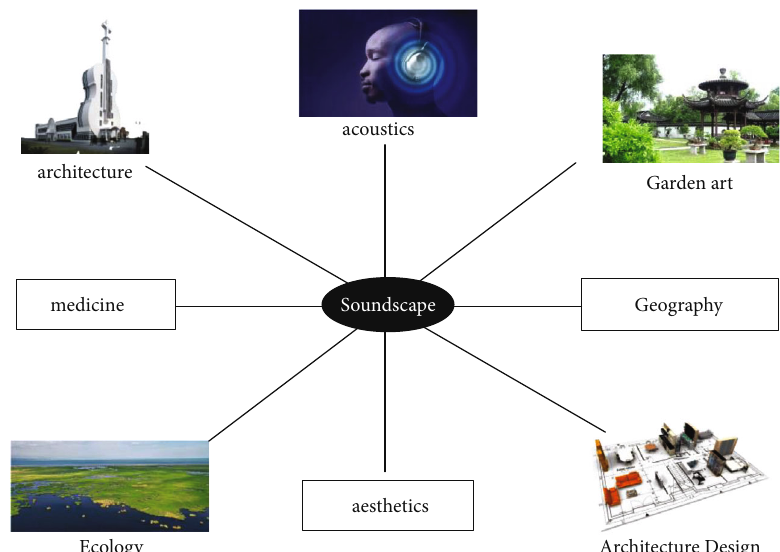
Figure 1: Application areas of